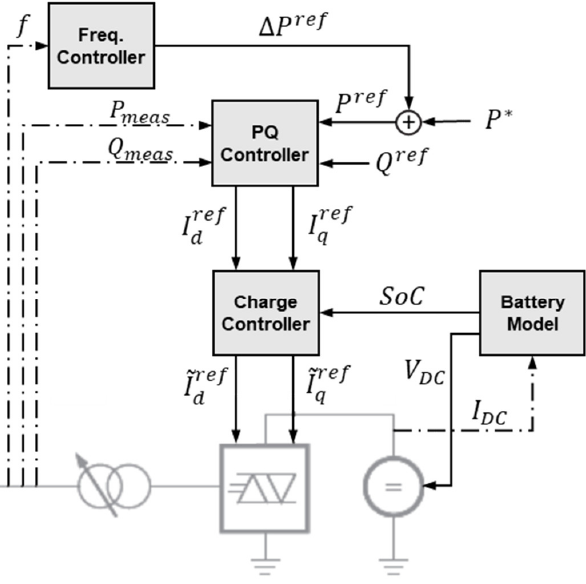
Figure 4. BESS model available from DIgSILENT PowerFactory [31].